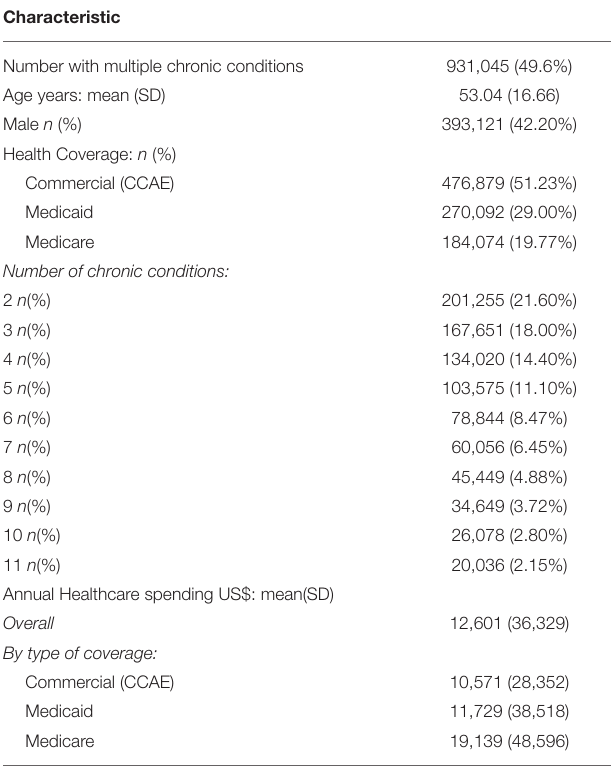
TABLE 1 | Characteristics of patients